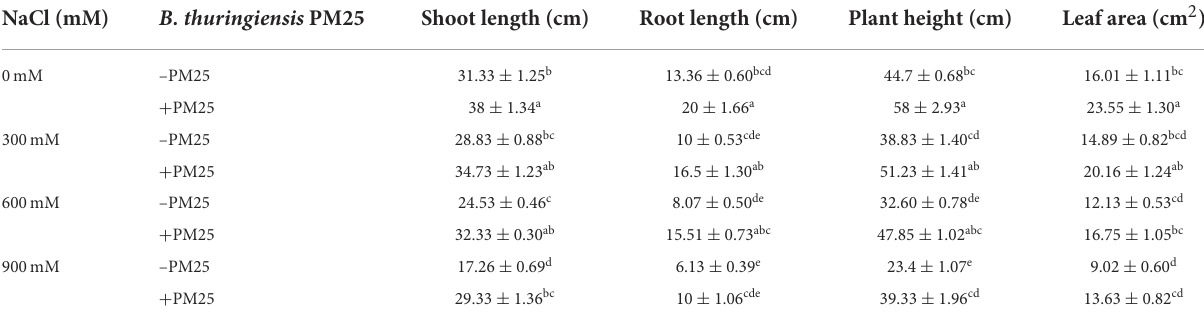
TABLE 2 Maize growth, biomass, and leaf surface area in the presence and absence of Bacillus thuringiensis PM25 under salinity